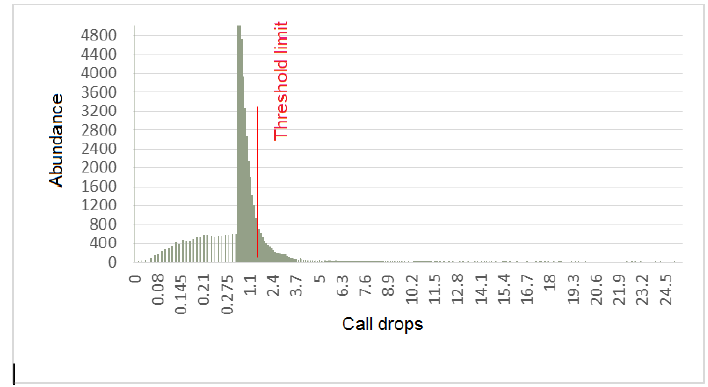
Figure 7. The histogram of the dropped calls in the data.